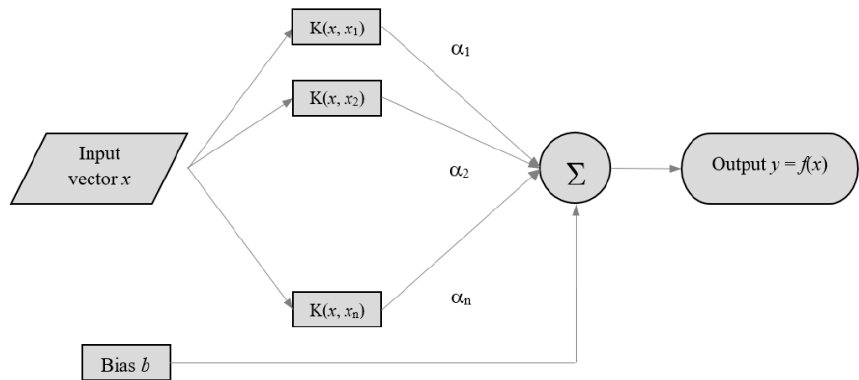
Figure 1. Network architecture of the SVR algorithms.